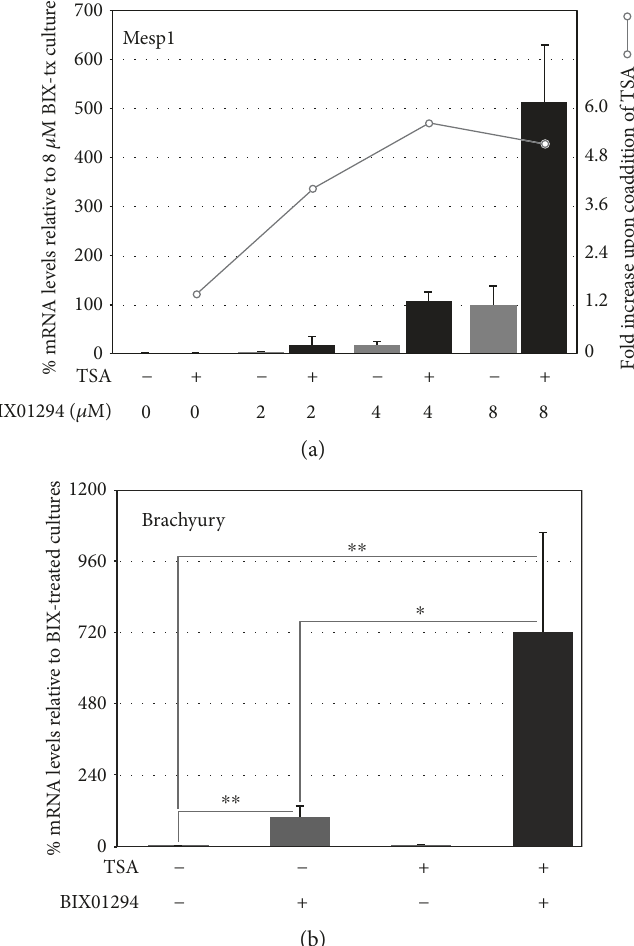
Figure 2: Synergistic enhancement of precardiac gene expression by bone marrow MSCs in response to coaddition of TSA with BIX01294. (a) MSCs were incubated for 48 hrs with various doses of BIX01294 in absence or presence of 50 nM TSA, prior to harvesting RNA and measuring Mesp1 expression by qPCR. On the left side of the chart, the y -axis is normalized to Mesp1 levels obtained from MSC cultures treated with 8 μ M BIX01294. The right side y -axis is scaled to the relative increase in Mesp1 expression resulting from the TSA coaddition to a given concentration of BIX01294. For this series of experiments, BIX01294 generated an ~ 160-fold increase in Mesp1 expression as compared to control levels, with TSA coaddition enhancing further the Mesp1 response an additional 5.6-fold. The numbers of biological repeats represented in the graphed data are as follows: 2 μ M BIX01294 and 2 μ M BIX01294+TSA ( n = 12 ), with remaining groups having n values =14. (b) RNA was assayed for brachyury expression by qPCR, following its isolation from MSC cultures incubated for 48hrs in the absence or presence of 8 μ M BIX01294 and/or 50 nM TSA. The coaddition of TSA synergistically enhanced BIX01294-stimulation of brachyury expression 7.2-fold ( n = 14 ; ∗ p < 0 05 ; ∗∗ p < 0 01